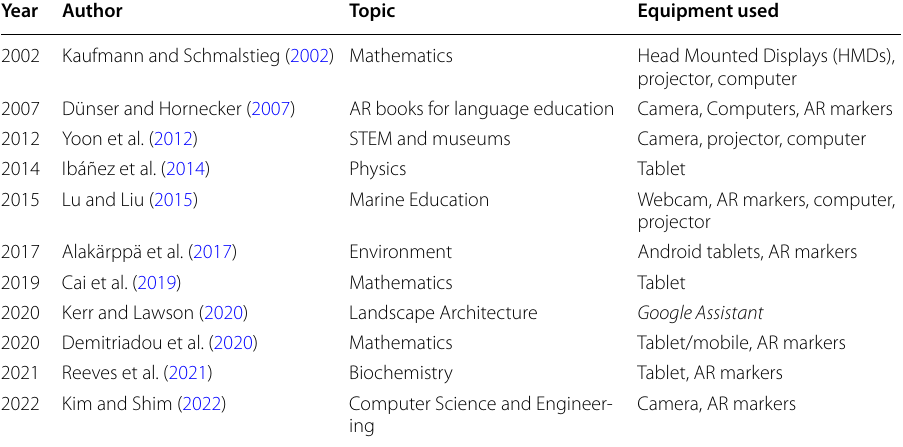
Table 5 Examples of AR applications used over the